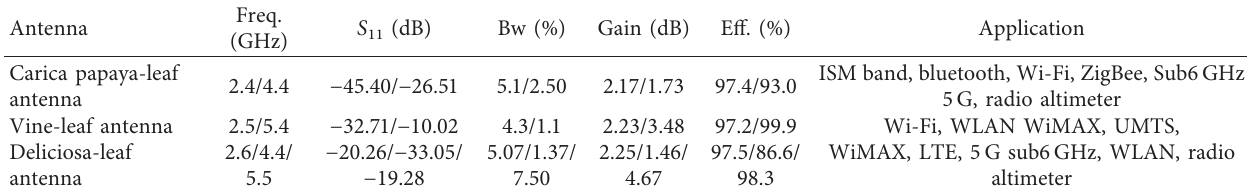
Table 3: Comparative analysis of the proposed antennas.